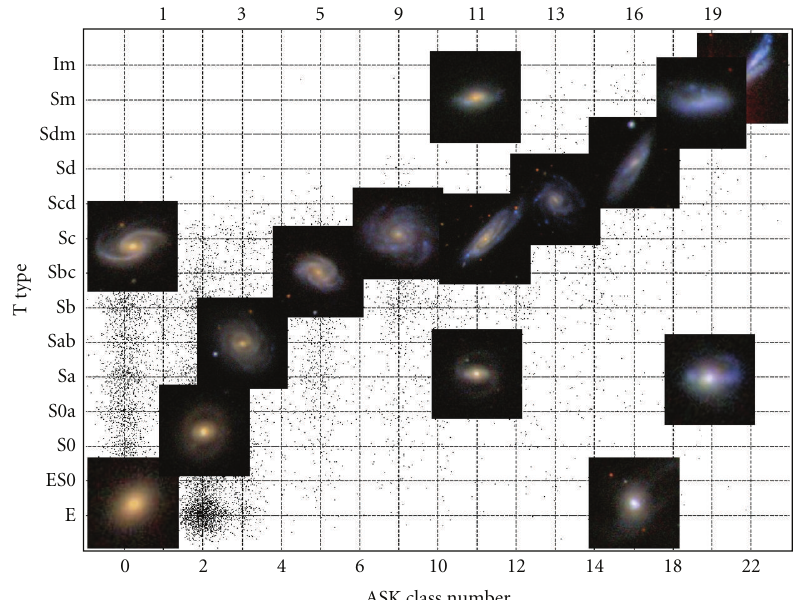
Figure 4: Scatter plot of Hubble versus spectral types. The sample of galaxies correspond to those galaxies classified visually by Nair and Abraham [28]. See more details in